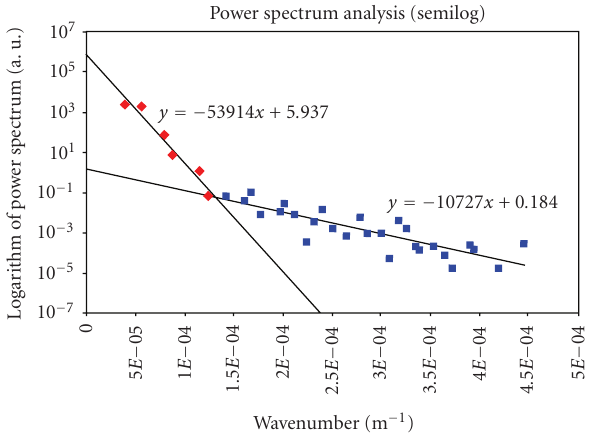
Figure 5: Results of the power spectrum analysis of the Bouguer gravity field using 2D Fast Fourier Transform. Black lines represent the trends of the linear regression separating the spectrum in a local trend (blue squares) and a regional trend (red